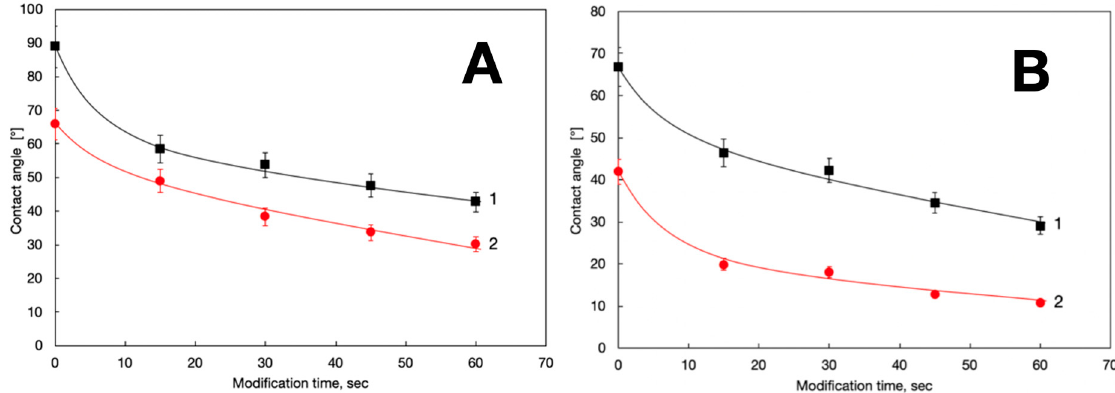
Figure 4. The dependences of the LDPE ( А ) and PET ( B ) substrates’ wetting contact angle with distilled water (1) and with ethylene glycol (2) on the duration of electro-induced multi-gas modification.